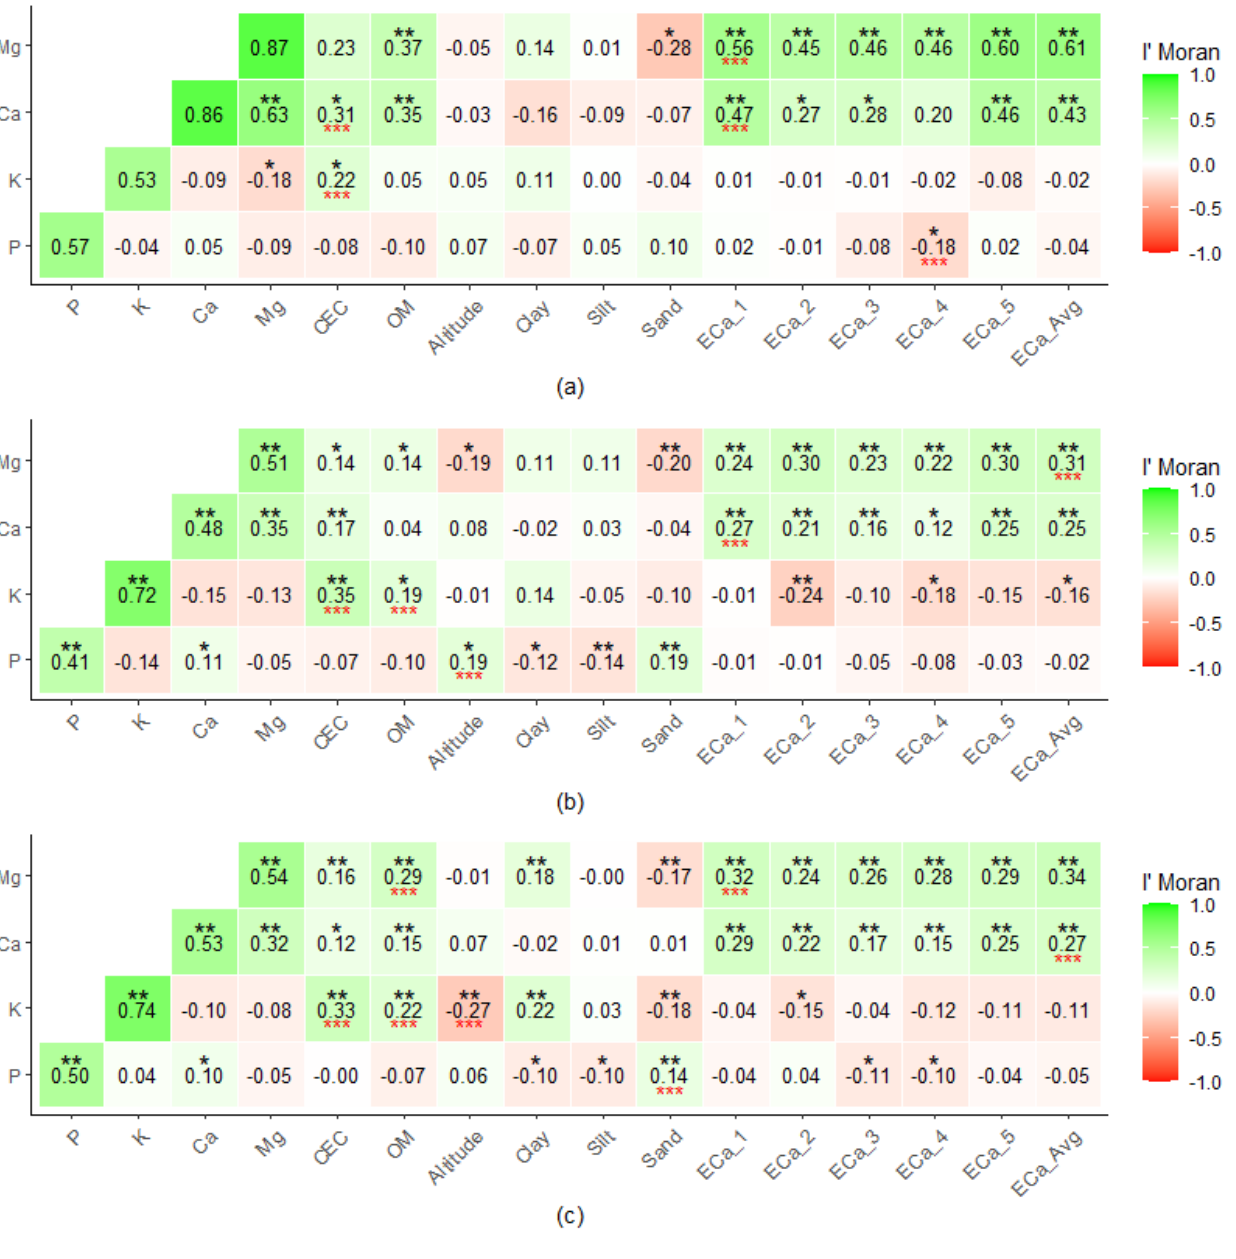
Figure 6. Univariate Global Moran’s Index for the soil attributes P, K + , Ca 2+ , and Mg 2+ and bivariate Moran’s Index among soil attributes P, K + , Ca 2+ , and Mg 2+ and covariates for the sampling grids of the training set with: ( a ) 38 points; ( b ) 75 points; ( c ) 112 points. *, ** indicating significance at 0.05 and 0.01 levels, respectively. *** covariates were used by the SVM2 method to interpolate the soil attributes P, K + , Ca 2+ , and Mg 2+ .